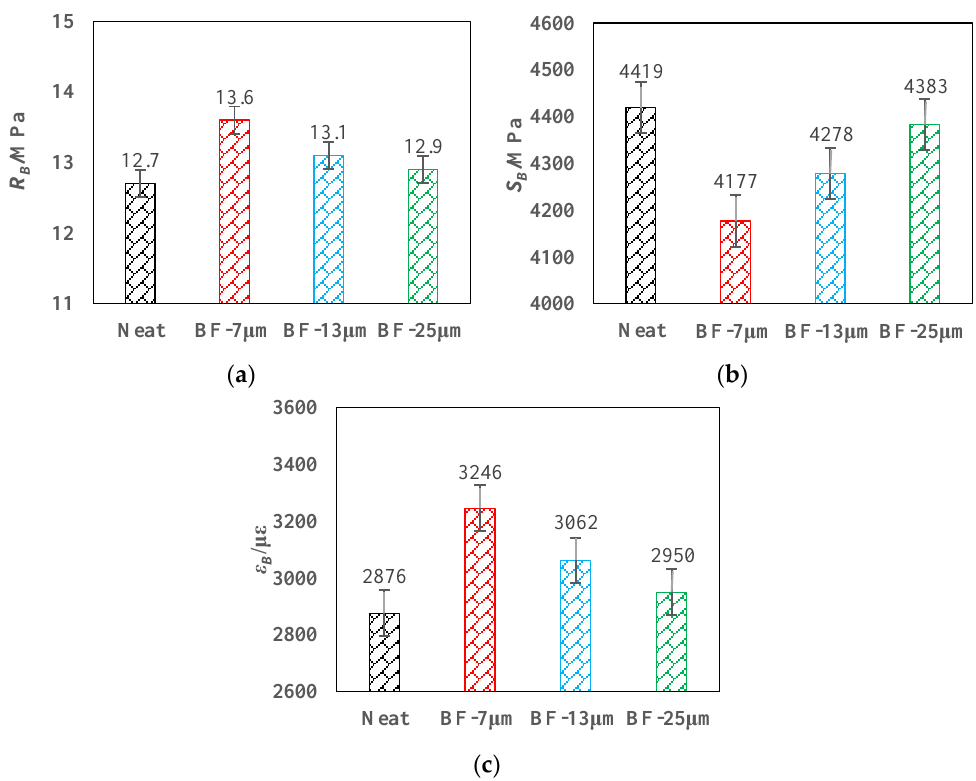
Figure 11. Low temperature trabecular bending test results: ( a ) flexural tensile strength; ( b ) flexural stiffness modulus; ( c ) maximum flexural tensile strain.